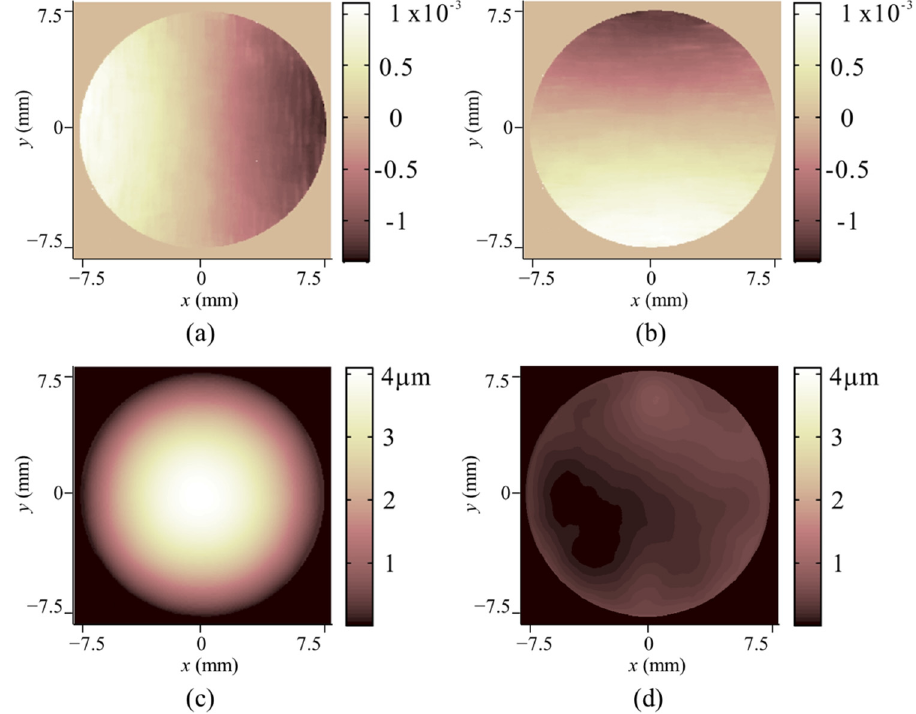
Figure 5. Deformation measured with interferometer and the proposed system. ( a ) gradient change in the horizontal direction measured with DeSDIC; ( b ) gradient change in the vertical direction measured with DeSDIC; ( c ) deformation measured with DeSDIC; and ( d ) point-to-point difference between the deformation maps measured with the two methods. The color bar of ( c ) and ( d ) is set the same to intuitively show the magnitude of the error.